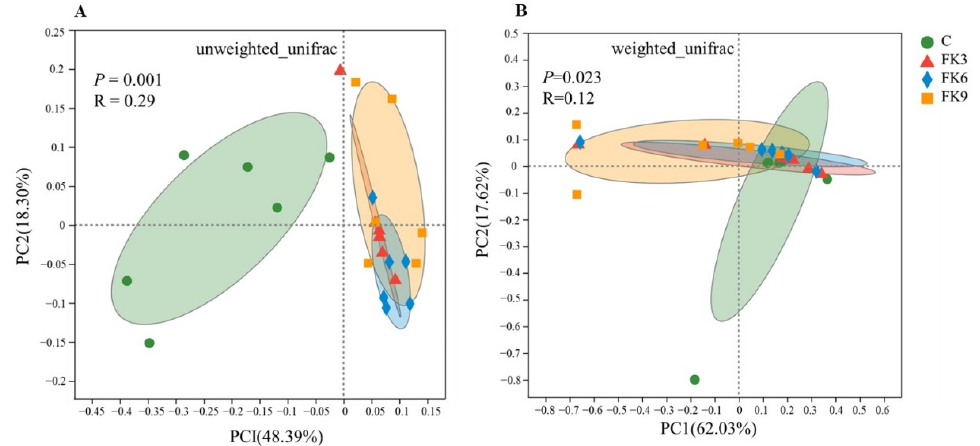
Figure 6. Beta diversity of microbiota in distal intestinal of largemouth bass fed diets with various FK levels. ( A ) PCoA plots based on Unweighted UniFrac show the clustering between treatments. ( B ) PCoA plots based Weighted UniFrac show the clustering between treatments.